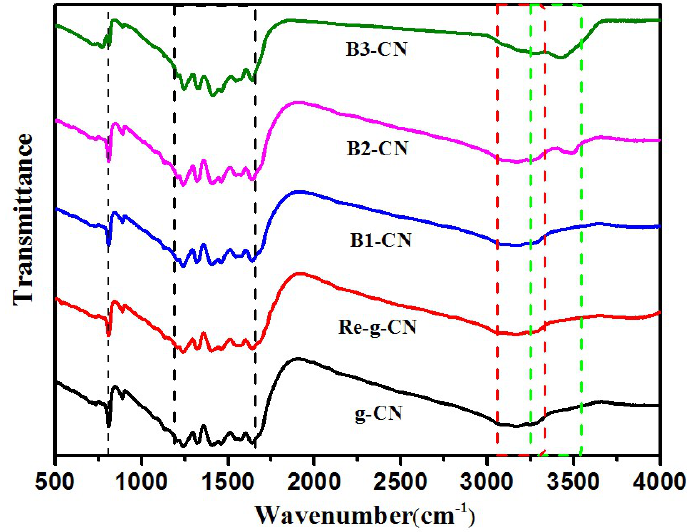
Figure 9. FT-IR spectra of CN, Re-CN, and CN/B 2 O 3 series materials.